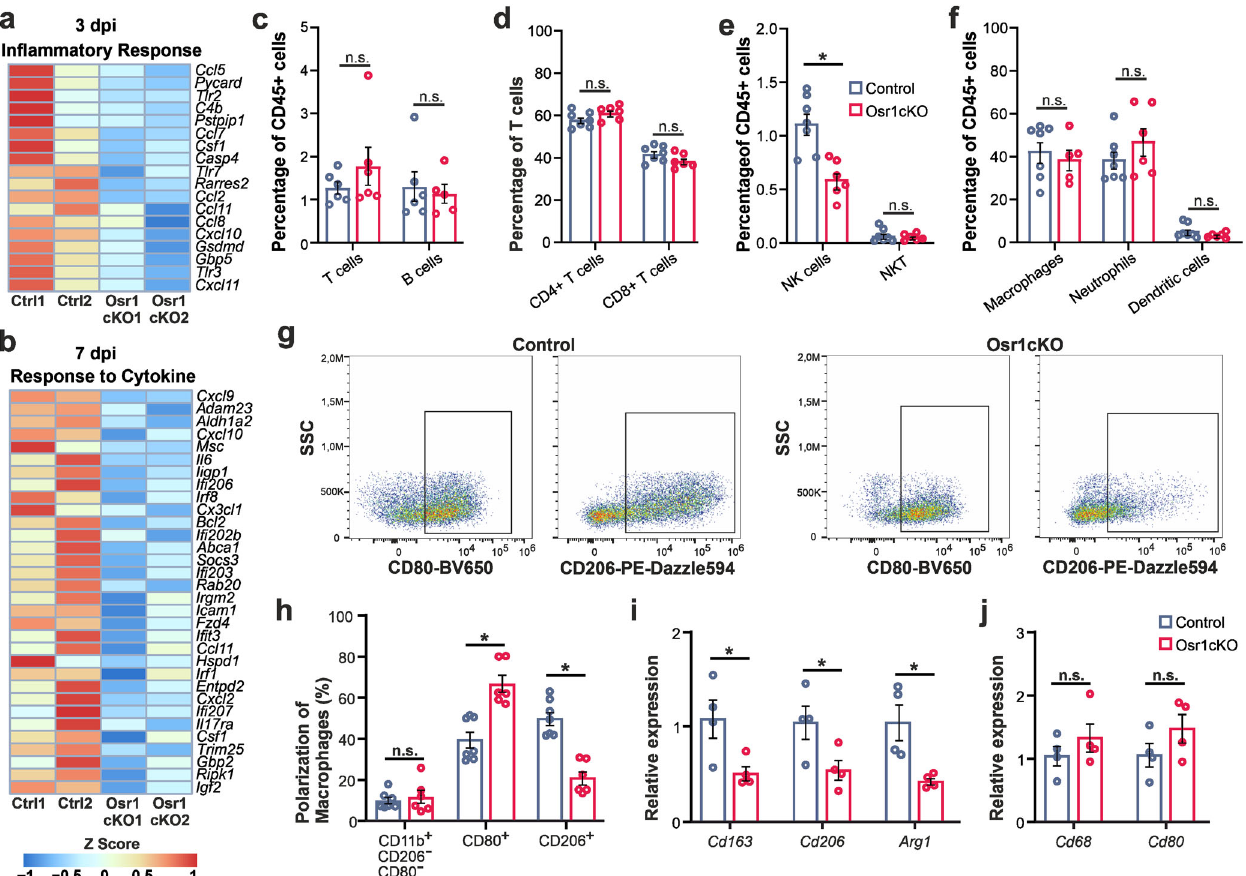
Fig. 4 Loss of Osr1 leads to altered macrophage polarization during skeletal muscle regeneration. a , b Heat maps of DE genes in 3 or 7 dpi control vs. Osr1cKO FAPs belonging to GO terms “ In fl ammatory response ” and “ Response to cytokine ” ( n = 2). c – f Relative quanti fi cation by fl ow cytometry of overall T- and B-cells (c), CD4 and CD8 T cells ( d ), NK/NKT cells ( e ) and myeloid subpopulations (f) isolated from control or Osr1cKO 3 dpi muscle ( n = 7 for control and n = 6 for Osr1cKO). g Representative FACS plots of CD80 / CD206 macrophage polarization analysis. h Quanti fi cation of non-activated (CD11b + /CD206 − /CD80 − ) and classically activated M1-like (CD80 + ) or alternatively activated M2- like (CD206 + ) macrophages in control or Osr1cKO muscle at 3 dpi. i , j RT-qPCR analysis of Cd163 , Cd206 and Arg1 , or Cd68 and Cd80 mRNA in whole muscle lysate ( n = 4). Data are represented as mean ± SEM; P ‐ value calculated by Mann – Whitney test in ( c – f ) and by two ‐ sided unpaired t test in ( h – j ) between control and Osr1cKO samples for each cell type; * p < 0.05. N ‐ numbers indicate biological replicates (mice per